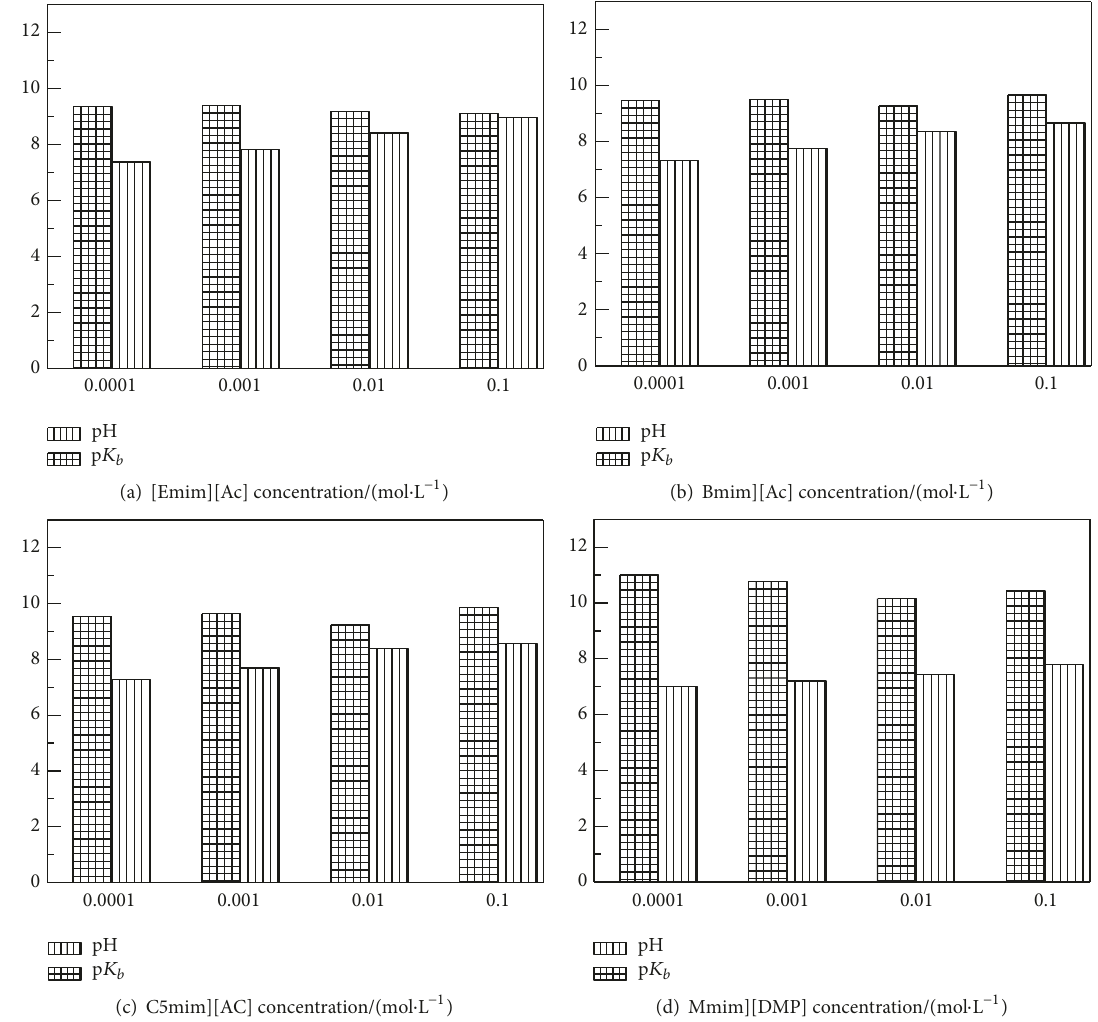
Figure 2: The pH and p 𝐾 𝑏 value of alkaline ionic